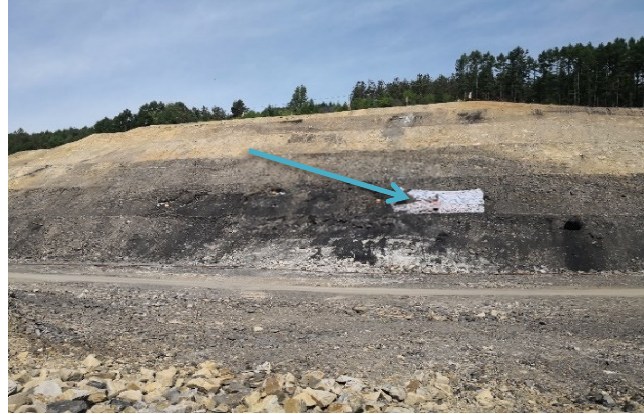
Figure 9. Collapsed mining face exposed to the side slope.